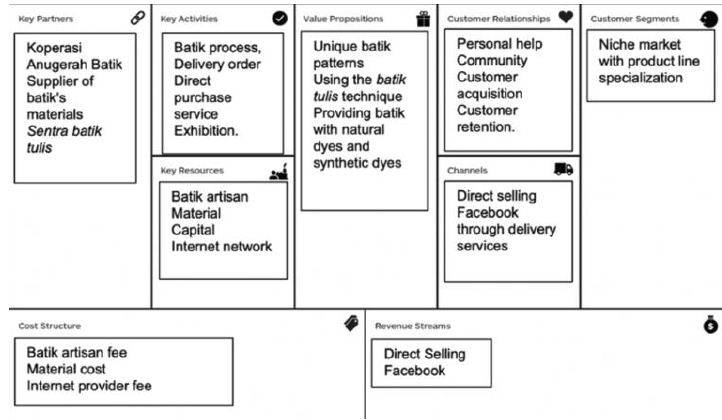
Figure 1: BMC of Batik Ciwaringin; Source: Hernama & Utomo (2015);